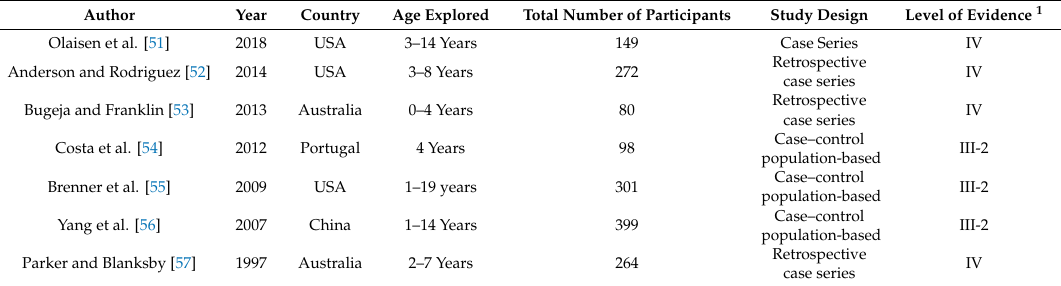
Table 2. Water competencies as an intervention for drowning prevention (included